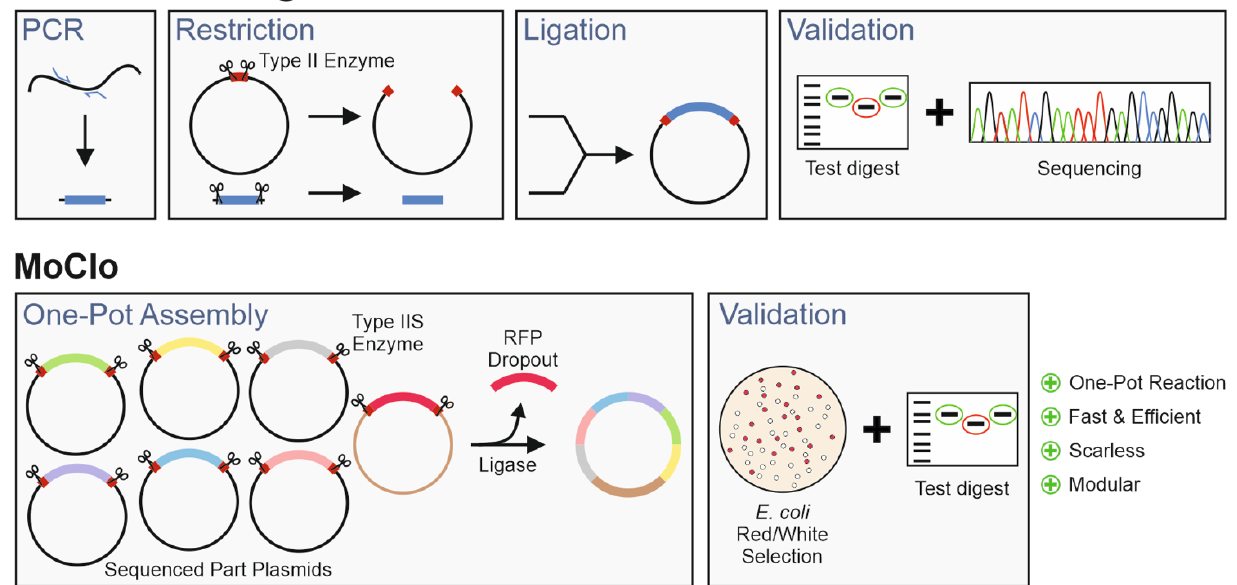
FIGURE 1: Comparison of the modular cloning (MoClo) workflow with that of classical cloning. Overview about the different steps in plas- mid construction by a classical cloning strategy with type 2 enzymes and of the MoClo strategy.